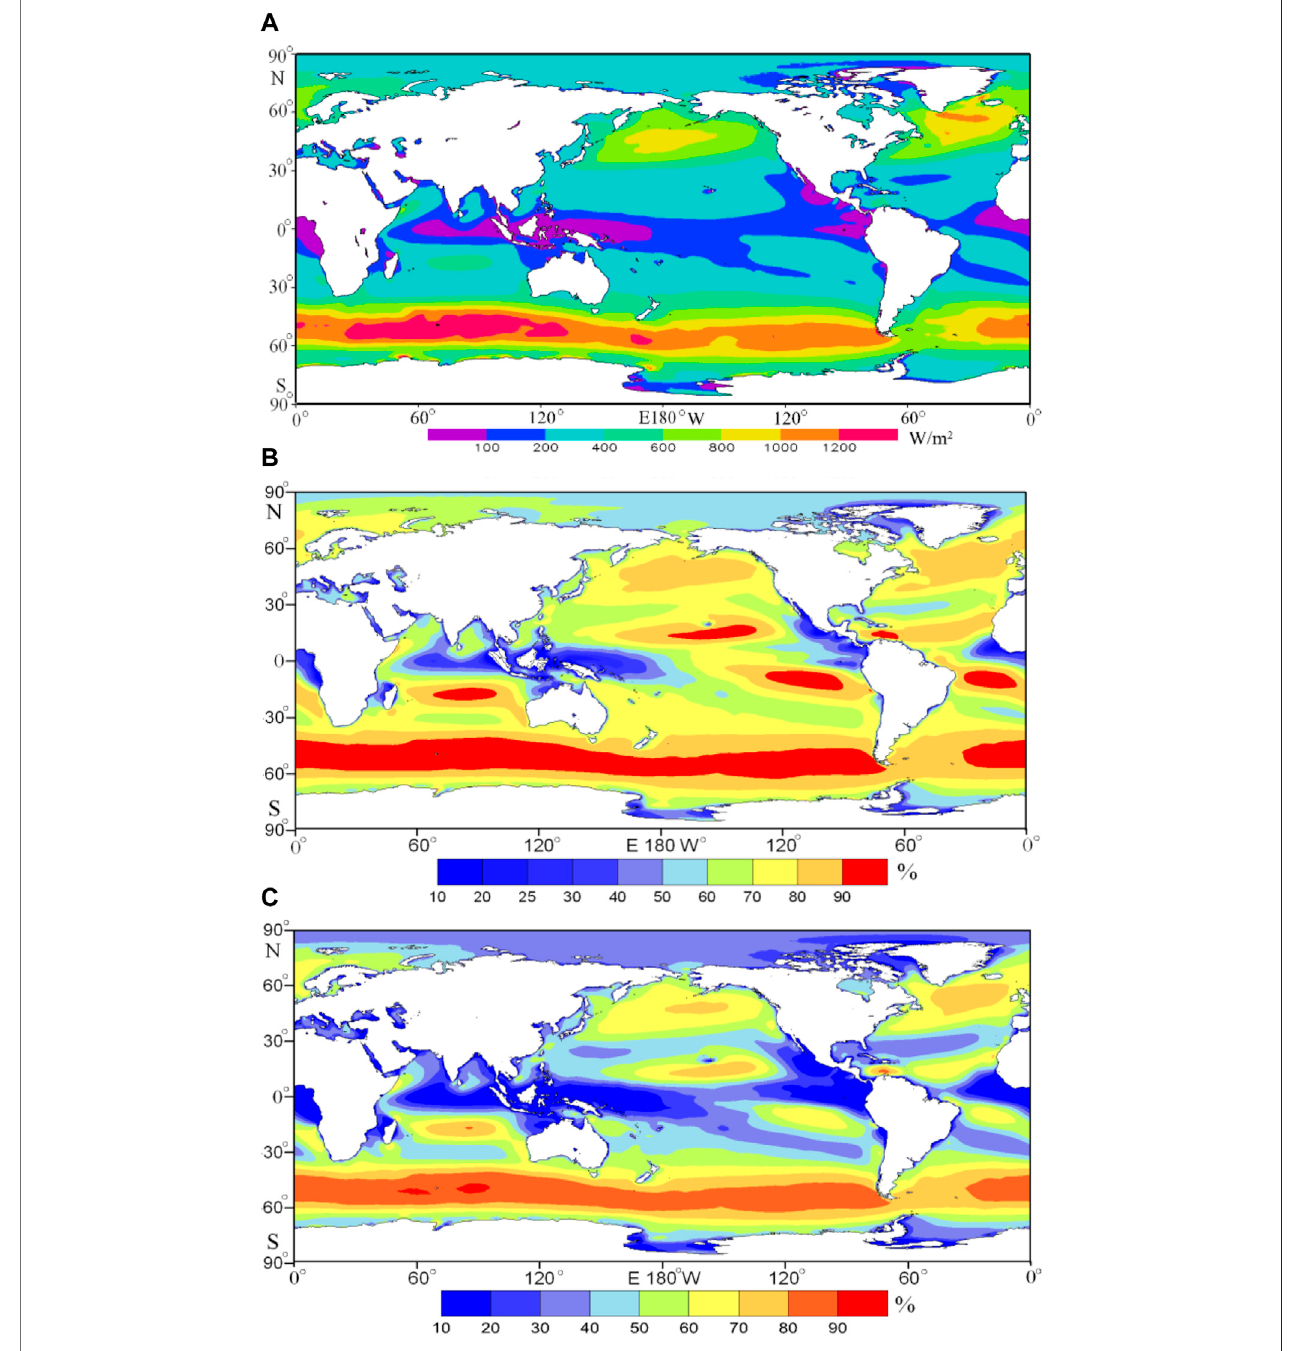
FIGURE 1 | Multi-year average wind power density (A) , effective wind speed occurrence (B) , and rich level occurrence (C) in the global oceans.